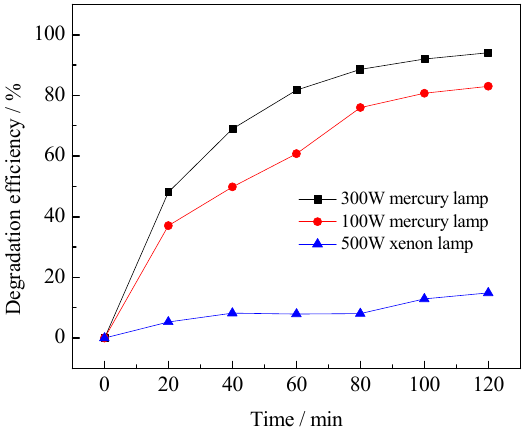
Figure 7. Effect of light intensity on photocatalytic degradation of benzohydroxamic acid. Reaction conditions: C (benzohydroxamic acid) = 30 mg·L − 1 , C (catalyst dosage) = 0.3 g·L − 1 , 0.75% La/TiO 2 , calcined temperature at 500 °C.